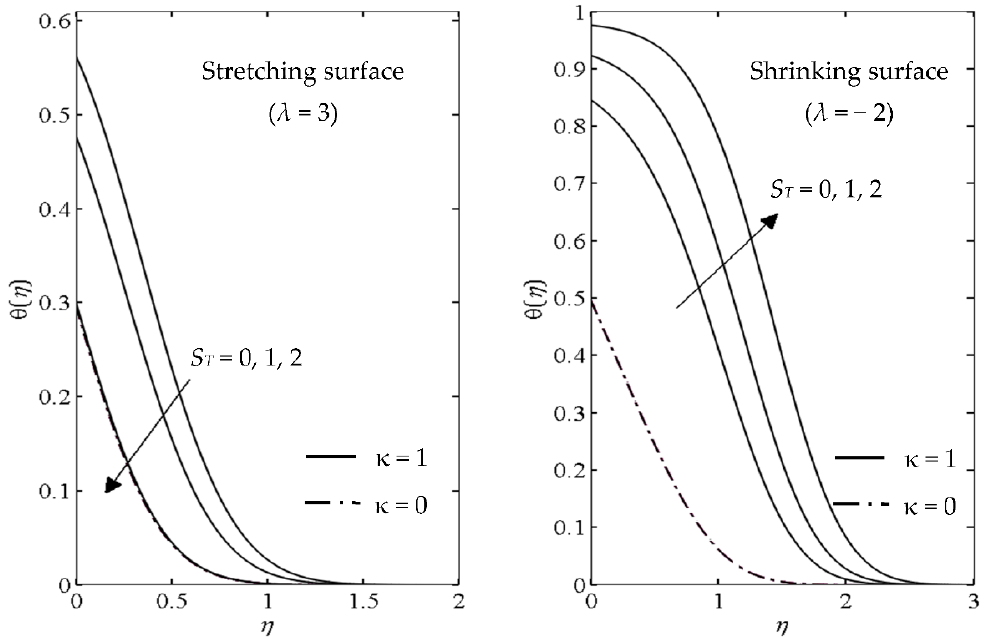
κ and λ . ters  and . 